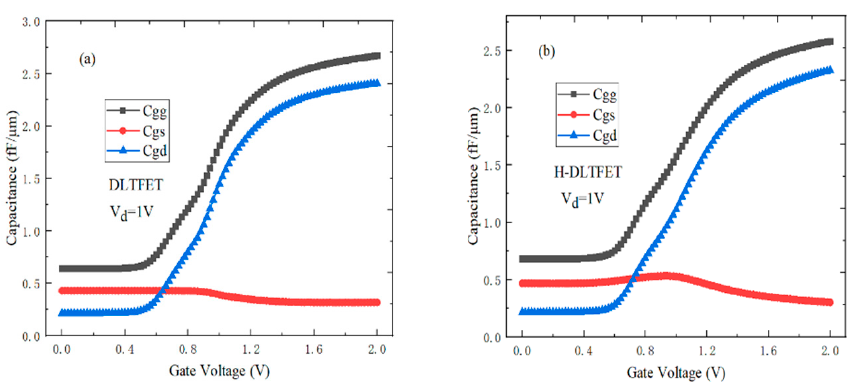
Figure 9. C-V characteristics of ( a ) the DLTFET and ( b ) the H-DLTFET.